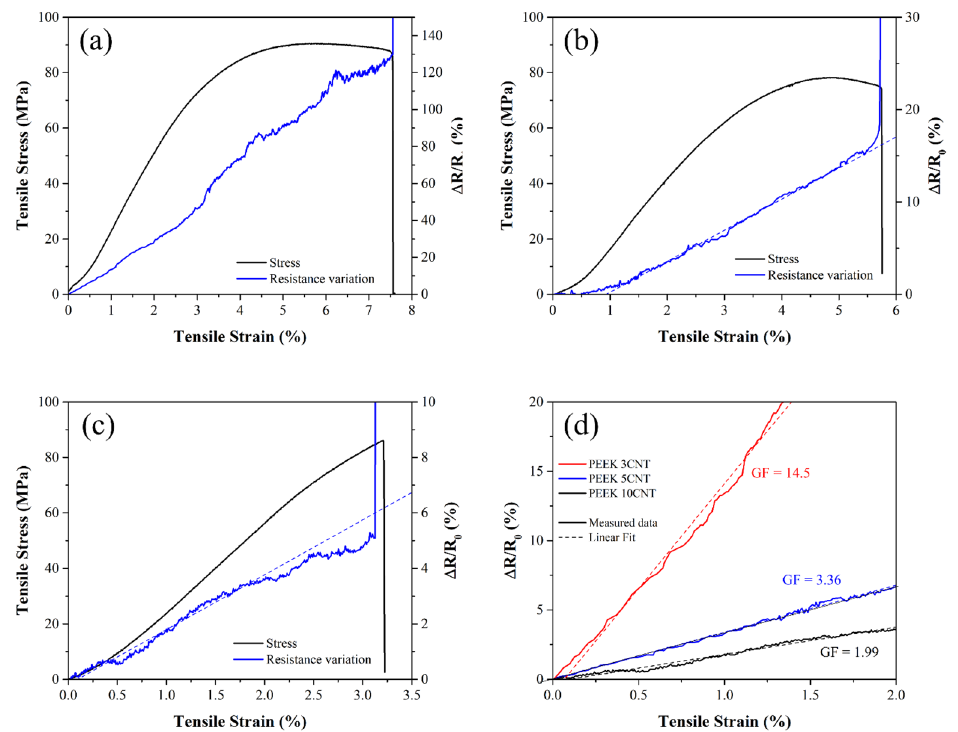
Figure 3. Tensile stress (black line) and electrical resistance (blue line) curves as a function of strain for ( a ) PEEK 3CNT, ( b ) PEEK 5CNT, and ( c ) PEEK 10CNT filament samples and ( d ) comparison of the electrical resistance variation for the filament samples with computed gauge factors.